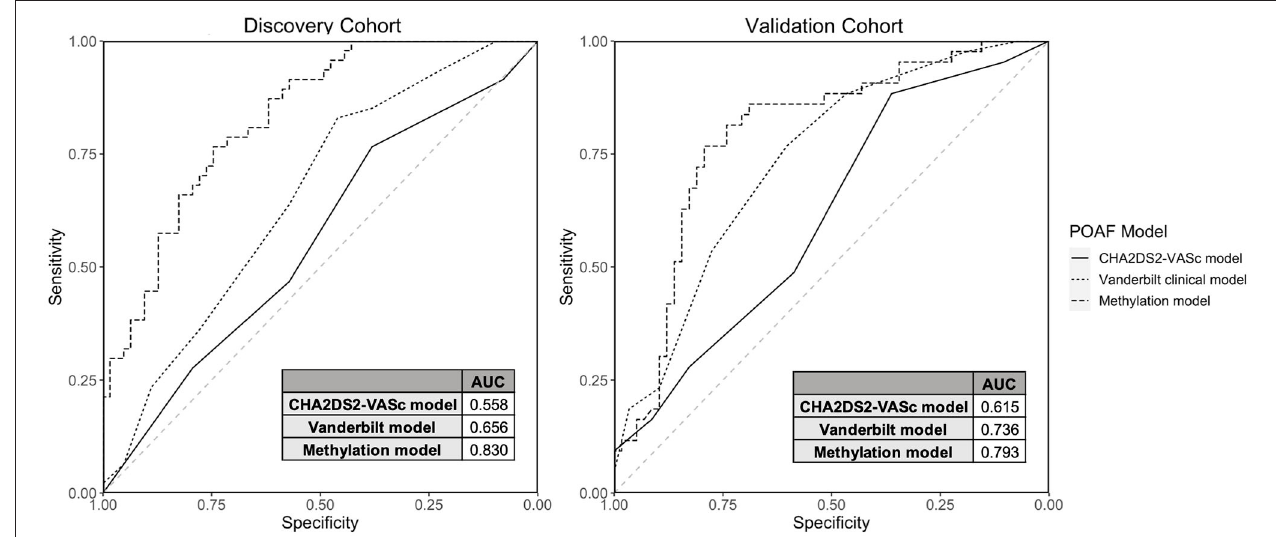
FIGURE 3 | Discovery and Validation Cohort Model Performance. ROC curves and AUCs are shown comparing model performance in the discovery and validation cohorts for the CHA 2 DS 2 -VASc model, the Vanderbilt Cardiac Surgery Registry clinical-only model and the methylation model (3 CpGs + 3 clinical risk